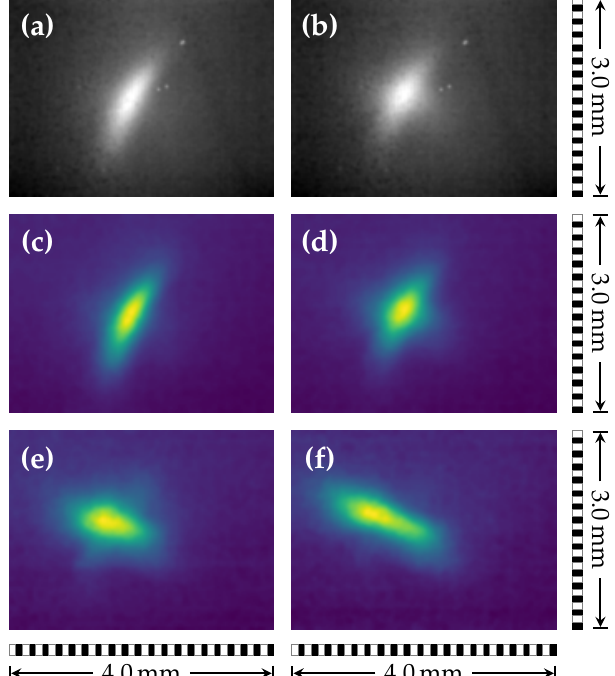
Figure 3. Selected single frames of a 1D real-time beam shape scan in the propagation direction. Data as saved from the camera software ( a , b ) and the same data for comparison in false-color with post-processing applied ( c , d ). Subfigures ( a , c , f ) depict the beam shape for two out-of-focus positions (before/after the focal point). The spatial intensity distribution close to the optimal focus is presented in ( b , d , e